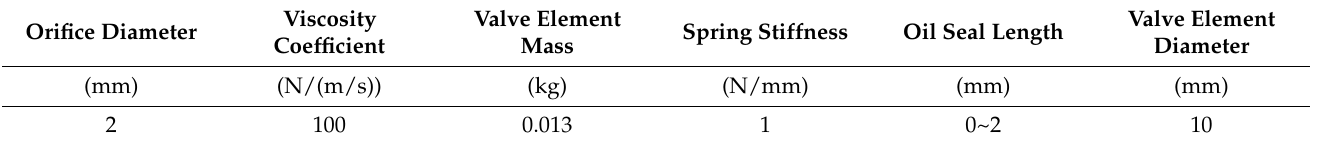
Table 5. Simulation parameters—group